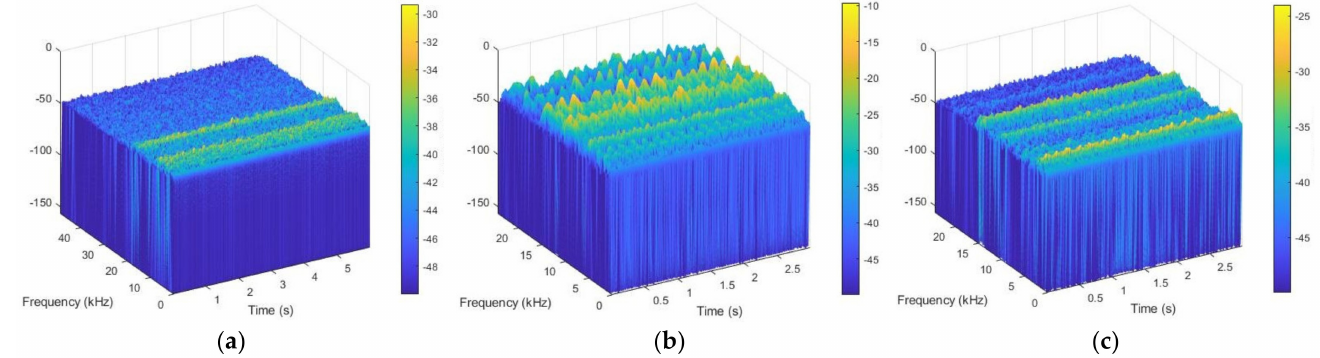
Figure 5. Input image of SECNN–BLS (( a ) is the image of the baseline rolling bearing, ( b ) is the inner race fault, and ( c ) is the outer race